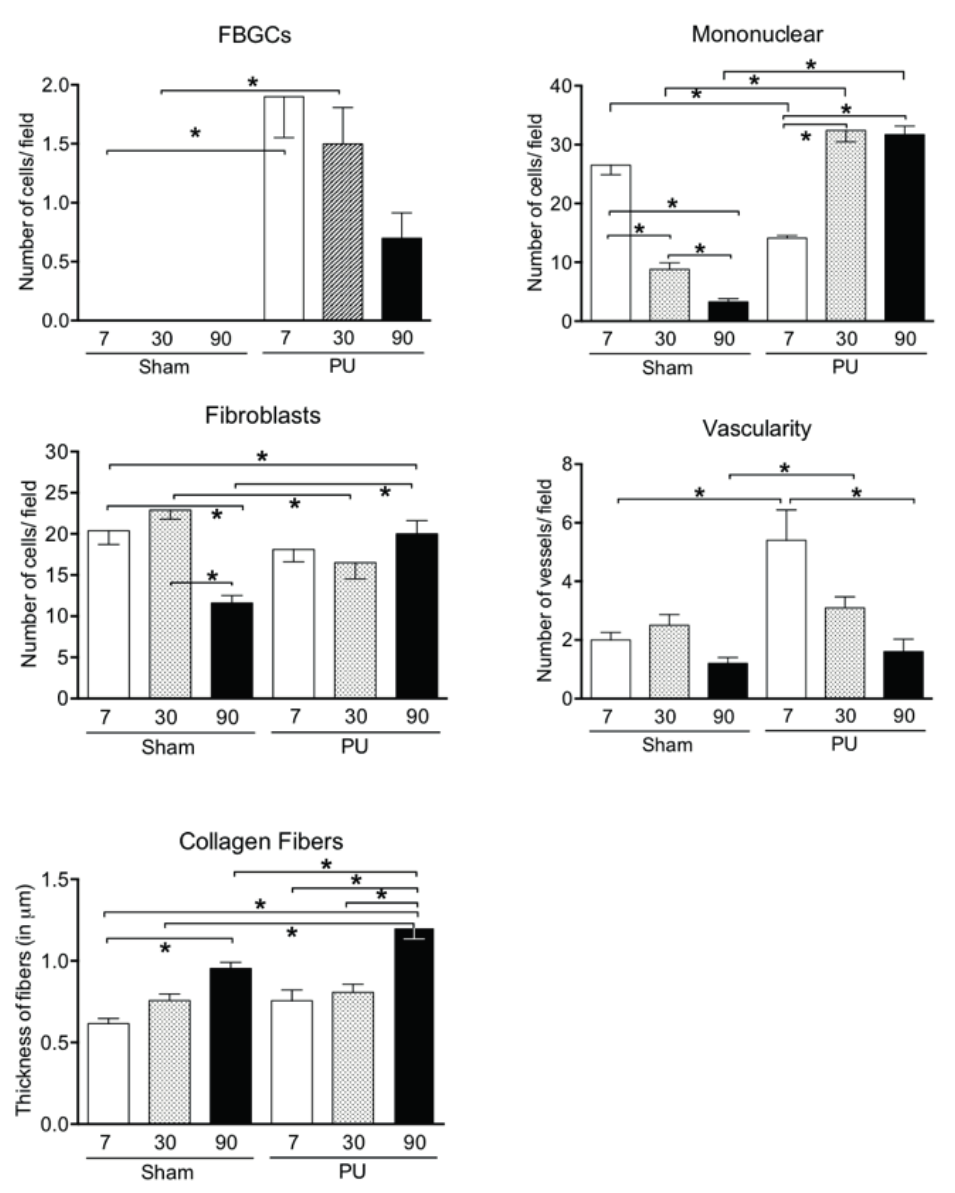
Figure 3 - Infl uence of PU on histologic parameters on dorsal skin of rats at diff erent time intervals (7, 30 or 90 days) after the implant. Data are presented as mean ± S.E.M. (n=8 animals per group). One-way ANOVA followed by Tukey’s test; (*) p < 0.05 in relation to control group